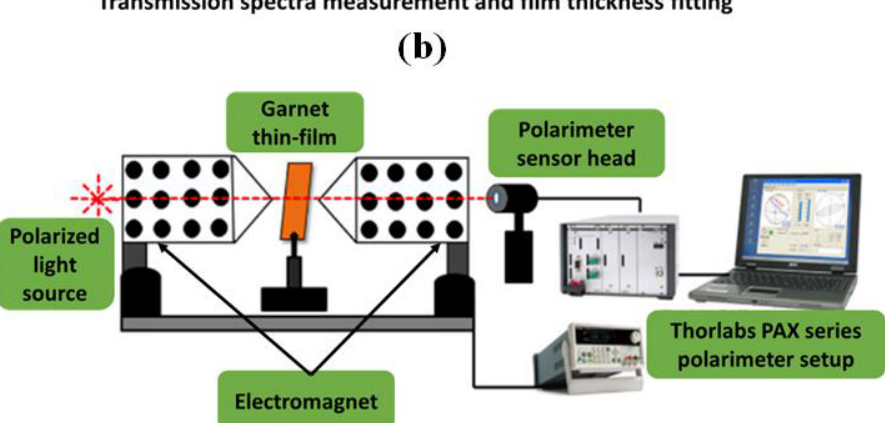
Figure 6. Schematic diagram of the annealing crystallization process of garnet layer ( a ), measurement of optical transmission spectra to derive the film thickness and absorption coefficient ( b ), and specific Faraday rotation and hysteresis loop of Faraday rotation characterization methodologies ( c ) [13].